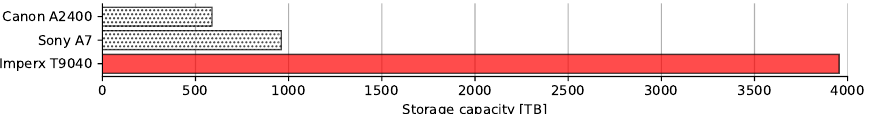
Figure 19. Storage required for storing images for the entirety of Europe in a single day from all